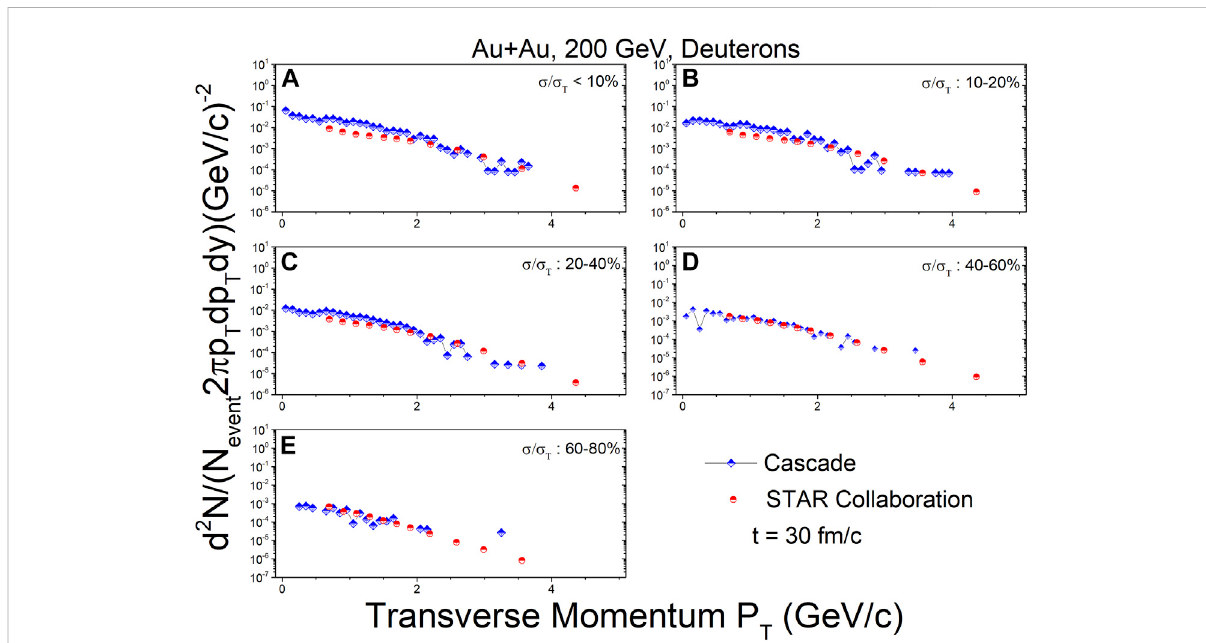
√ (cid:1)(cid:1)(cid:1)(cid:1) s NN = 200 GeV Au + Au collisions, 0, − ,10%, 10, − ,20%, 20, − ,40%, 40, − ,60% and 60, − ,80% centrality in t = 30 fm / c in the deuteron In the transverse momentum spectrum. Calculations are represented by signs + lines. Experimental data from the STAR collaboration [27] are represented as circles. The parameter sets of ( R 0 , P 0 ) is (3.575 fm, 0.285 GeV/ c ).